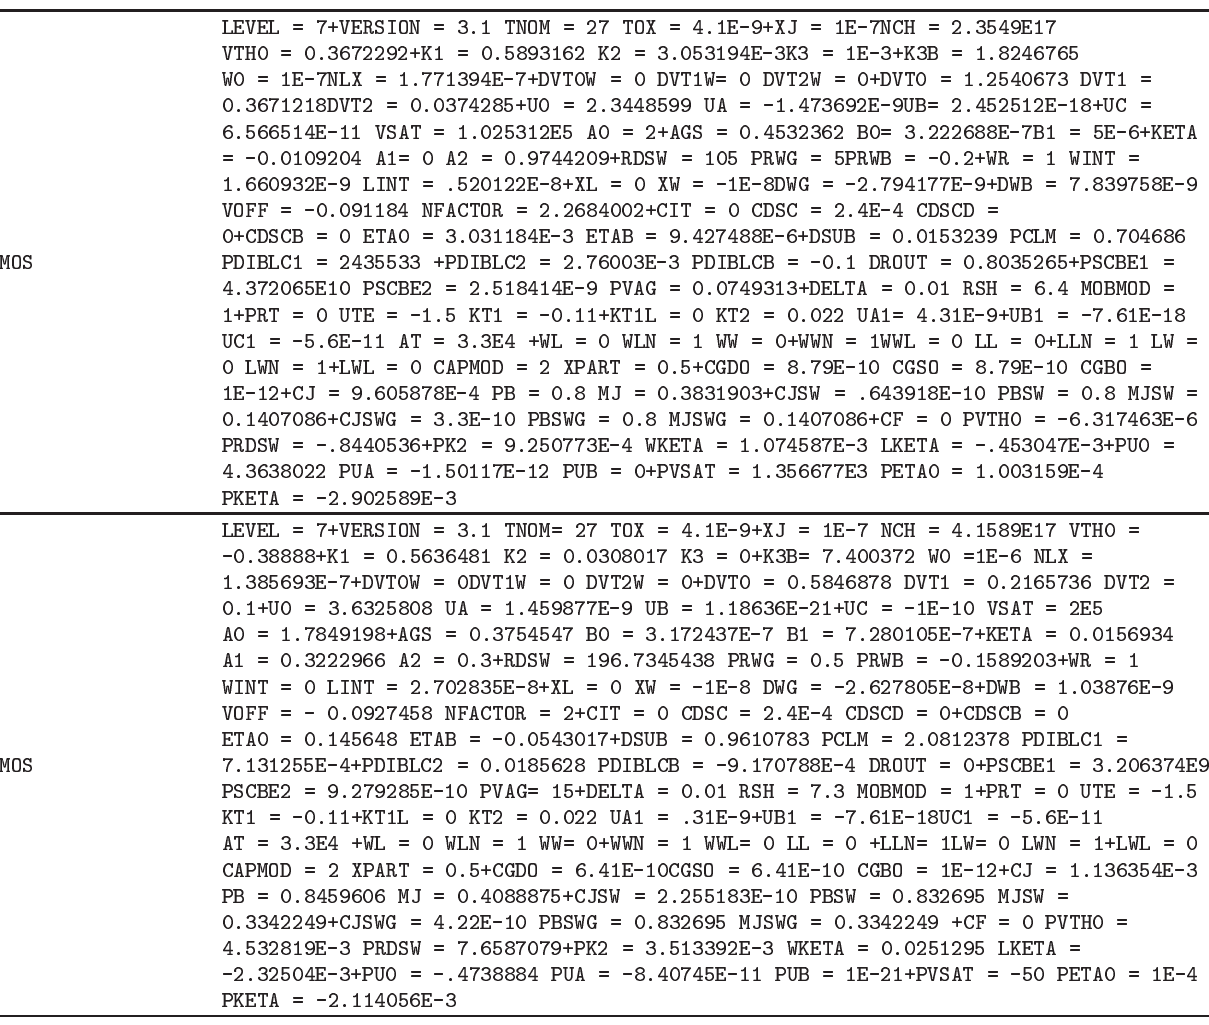
Table 2: List of 0.18 𝜇 m CMOS process parameters